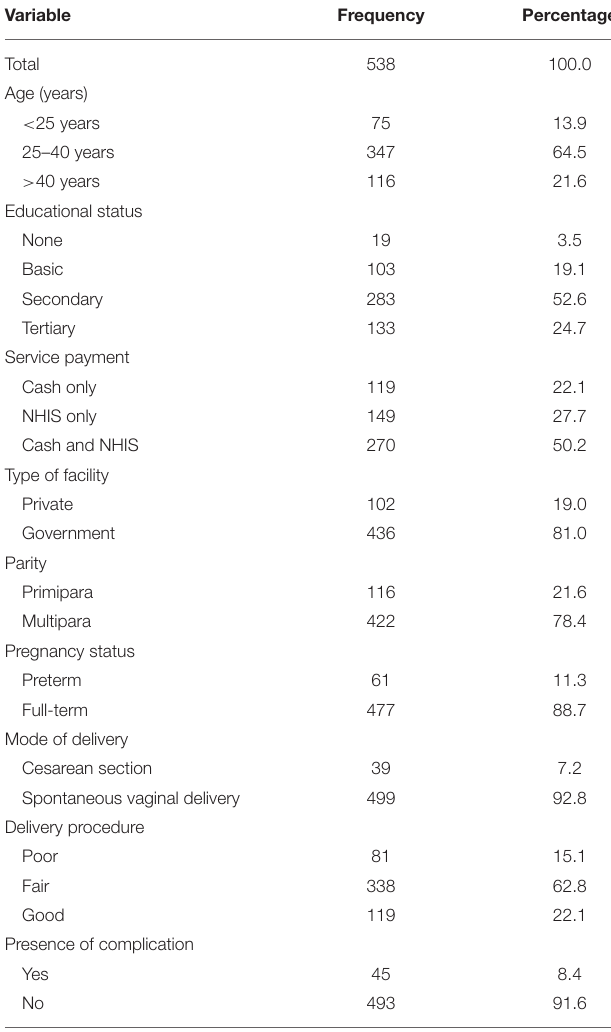
TABLE 1 | Sociodemographic characteristics, pregnancy-related factors and health statuses of the respondents ( n = 538).